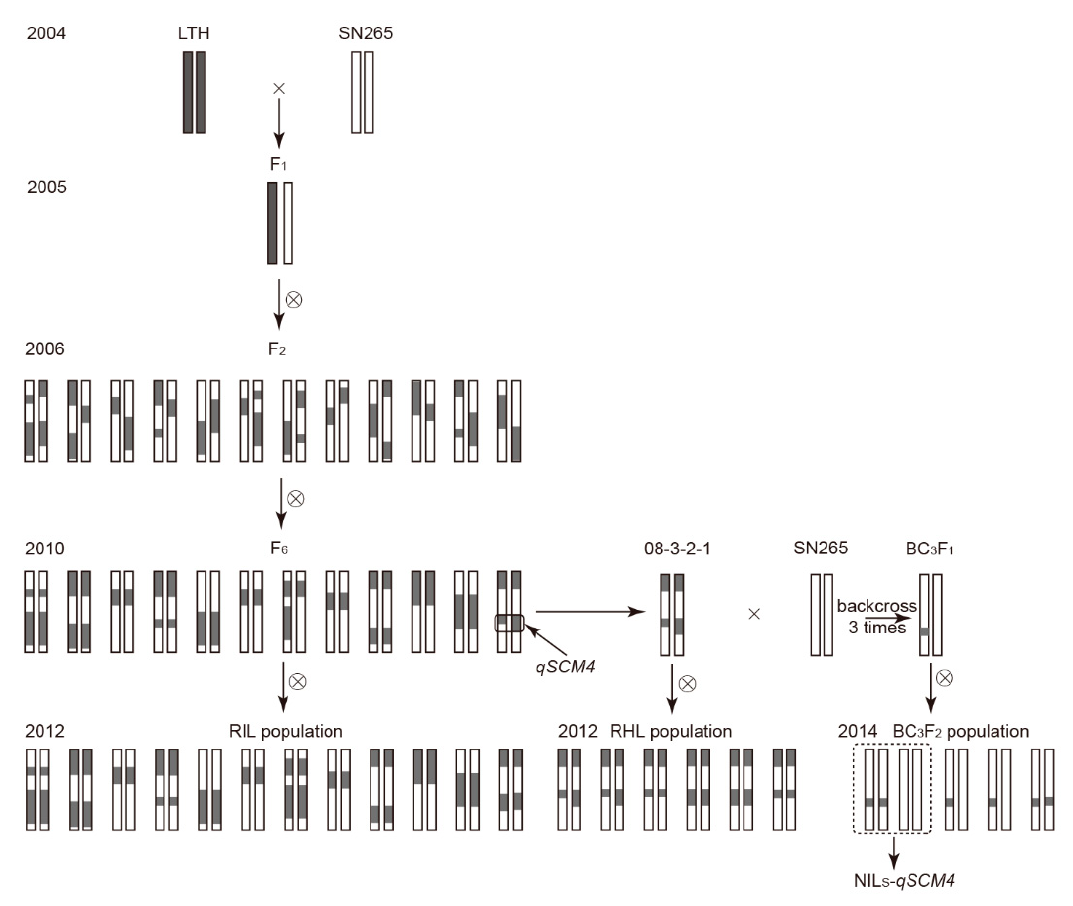
Figure 4. The building process of F 2 population, RILs population, RHLs population and BC 3 F 2 population used in this study.